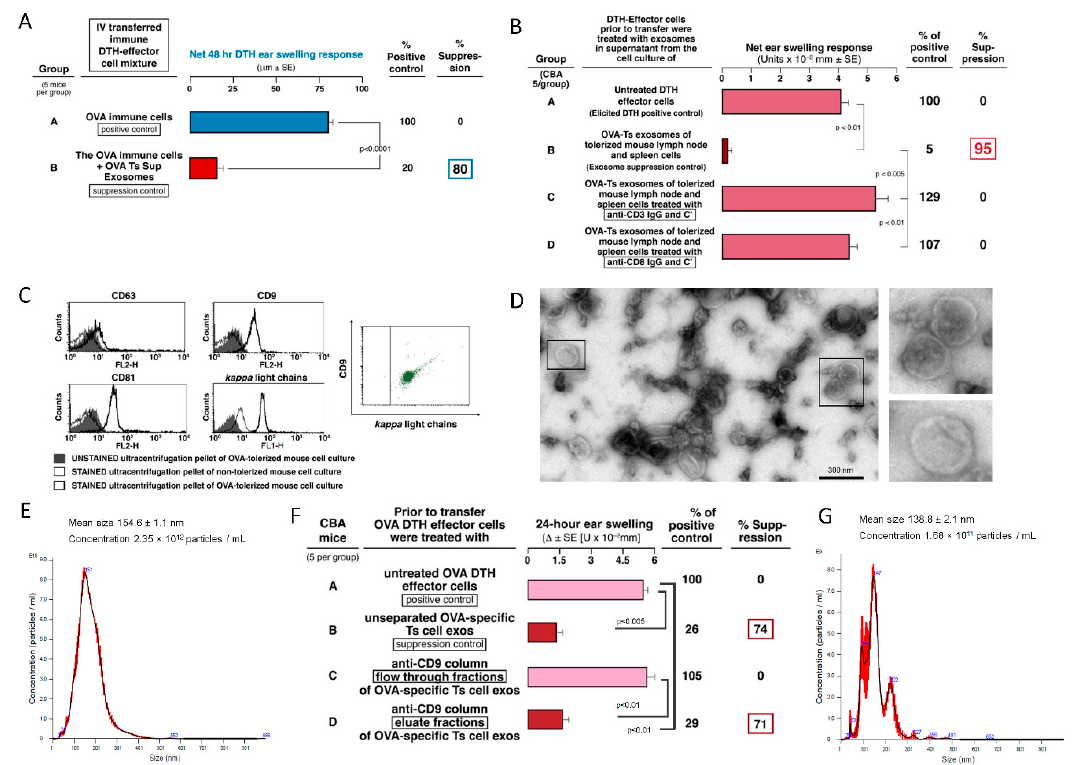
Figure 1. OVA Ag-specific Ts cell-derived, CD9 + exosomes inhibit adoptive transfer of T cell mediated DTH. ( A ) OVA Ag-specific suppressor T cell-derived exosomes inhibit OVA-immune DTH effector cells (Group B, 80% suppression) undergoing adoptive transfer of DTH (Group A, immune response control). ( B ) Lymph node and spleen cells of Ag-tolerized mice failed to produce suppressive exosomes when depleted of CD3 + (Group C) and CD8 + (Group D) cell populations vs. their exosome suppression control (Group B, 95% suppression). ( C ) Flow cytometry showing that OVA-specific Ts cell-derived exosomes express CD9, CD63 (weakest expression), and CD81 tetraspanins, as well as antibody kappa light chains (left and center), and simultaneously co-express CD9 and antibody light chains (right). ( D ) OVA-specific suppressive exosomes were analyzed with transmission electron microscopy, that showed the presence of nanovesicles with bilamellar membranes. ( E ) Nanoparticle tracking analysis of OVA-specific Ts cell-derived exosomes to estimate their size and concentration. ( F ) OVA-specific suppressive exosomes were separated onto an anti-CD9-affinity chromatography column. The resulting anti-CD9 binding and non-binding exosome fractions were then used to treat OVA DTH effector cells prior to their adoptive transfer into naive recipients that 24 h later were challenged with OVA. The elicited DTH ear swelling responses were measured 24 h later with an engineer’s micrometer, showing that the full suppressive activity of the Ts cell-derived exosomes was in the anti-CD9 binding and eluted fraction (about 10% of the total) and there was no suppressive activity in the non-binding flow through fraction (Group D vs. C, 71% suppression vs. 0% suppression). ( G ) Nanoparticle tracking analysis of OVA-specific Ts cell-derived exosomes present in the eluate fraction resulting from separation onto an anti-CD9 affinity chromatography column, to estimate their size and concentration. Results of in vivo assays are shown as delta ± standard error (SE), one-way ANOVA with post hoc RIR Tukey test. n = 5 mice in each group or three samples in each experimental repetition.